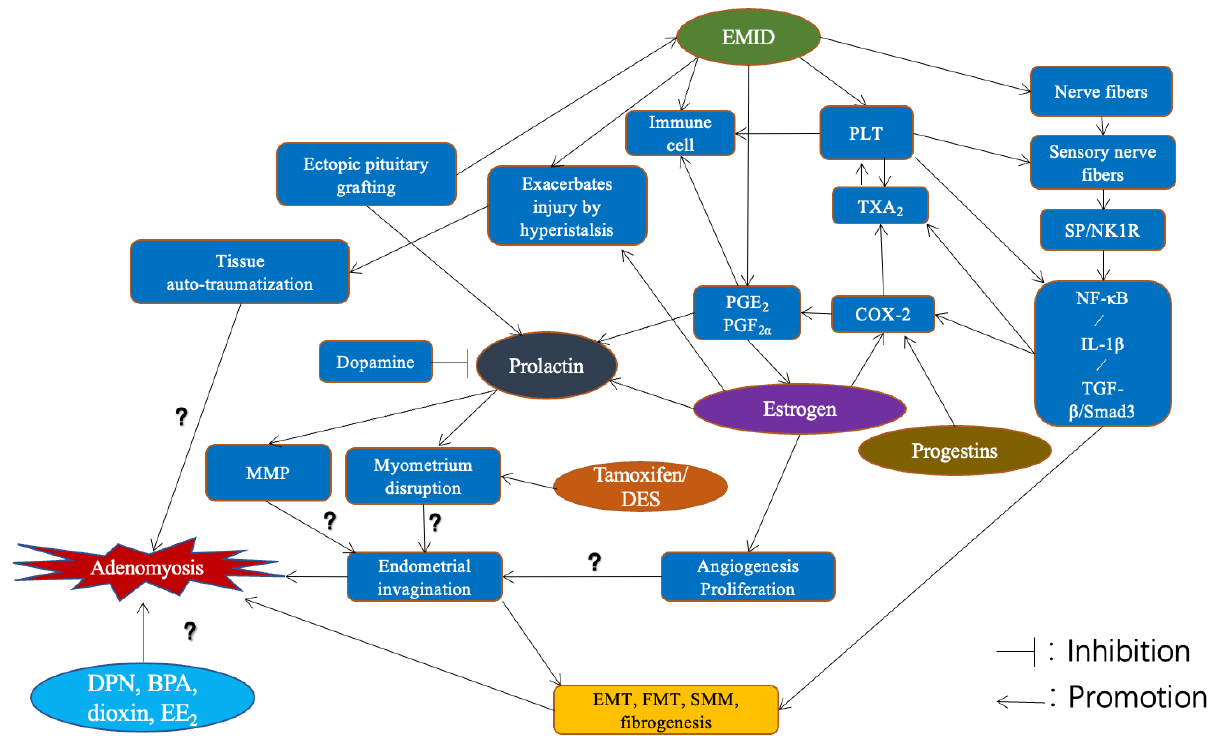
Figure 3. Schematic illustration of different animal models of adenomyosis, along with their possible mechanisms. Abbreviations used: SP—substance P; TXA 2 —thromboxane A 2 ; COX-2—